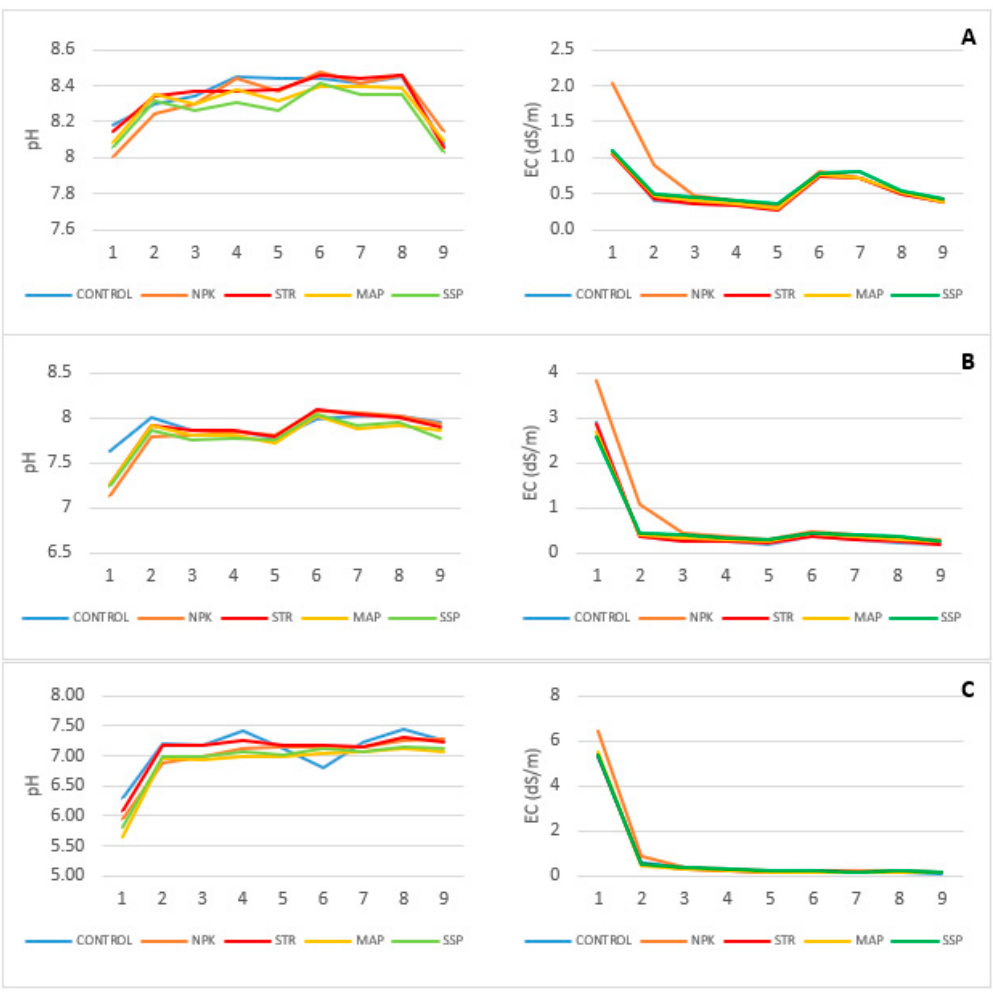
Figure 1. pH and electrical conductivity (dS/m) of leachates in alkaline ( A ), neutral ( B ), and acidic ( C )